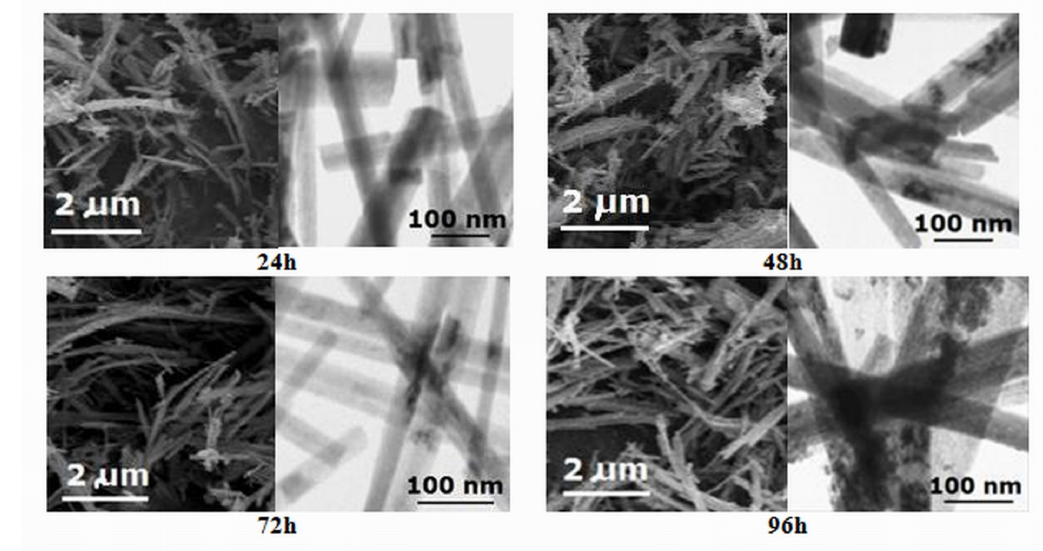
Figure 6: SEM (left) and TEM (right) of samples prepared for different reaction